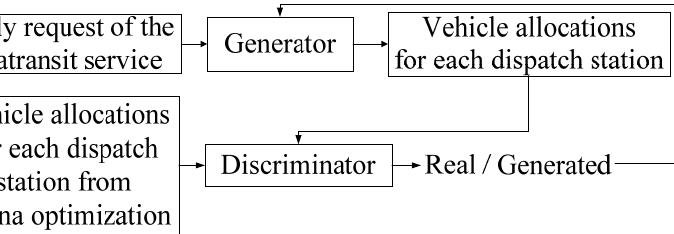
Figure 4. GAN model used in this work, where generator input is the historical daily request from Arena simulation and discriminator input is the optimized vehicle allocation from Arena.